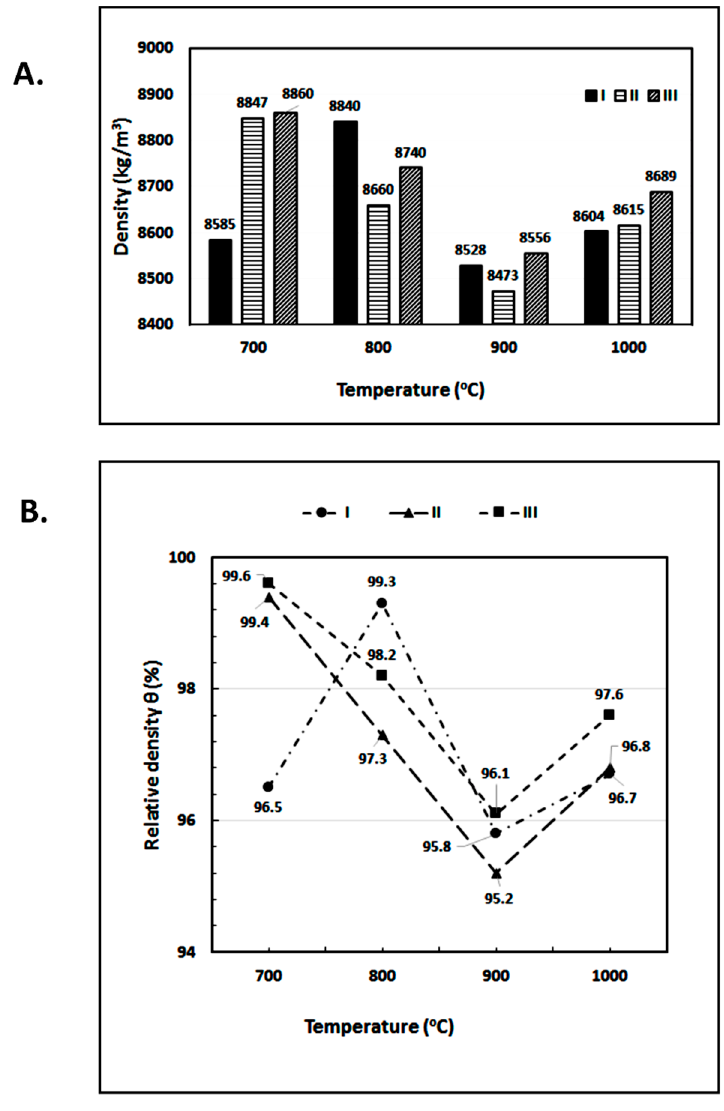
Figure 7. Influence of sintering temperature on ( A ) absolute densities and ( B ) relative densities of three sets of Co powders.